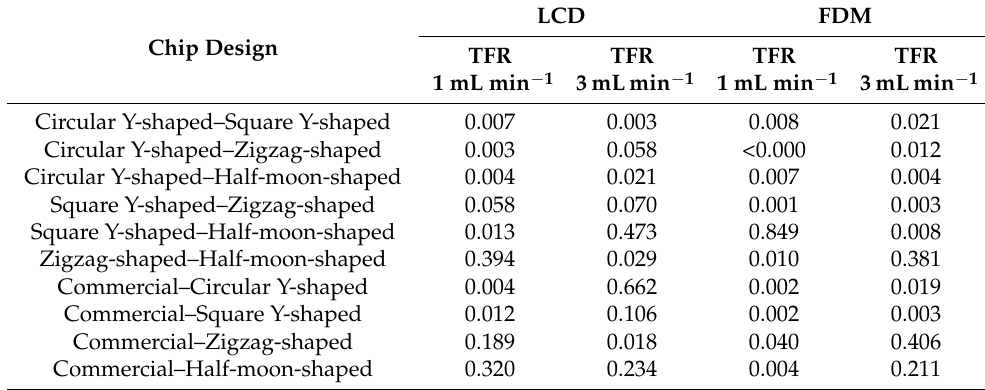
Table 4. Values tabulated are two-tailed p -values calculated from mean sizes of liposomes formulated with commercial and developed chips using LCD and FDM printers at TFRs of 1 and 3 mL min − 1